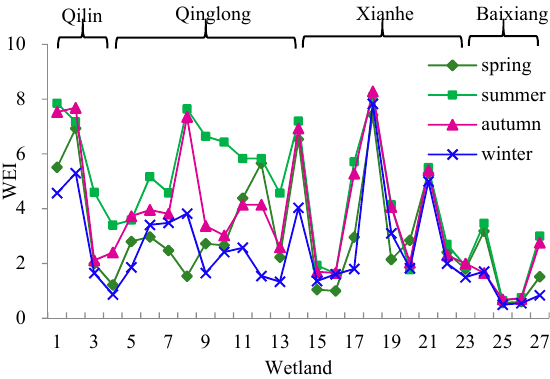
Figure 5. WEI seasonal values in different watersheds in different seasons.